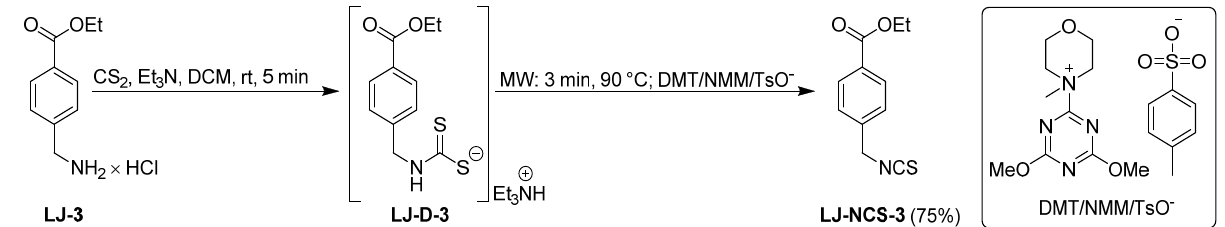
Figure 2. Microwave-assisted synthesis of LJ-NCS-1, LJ-NCS-4, and LJ-NCS-5.